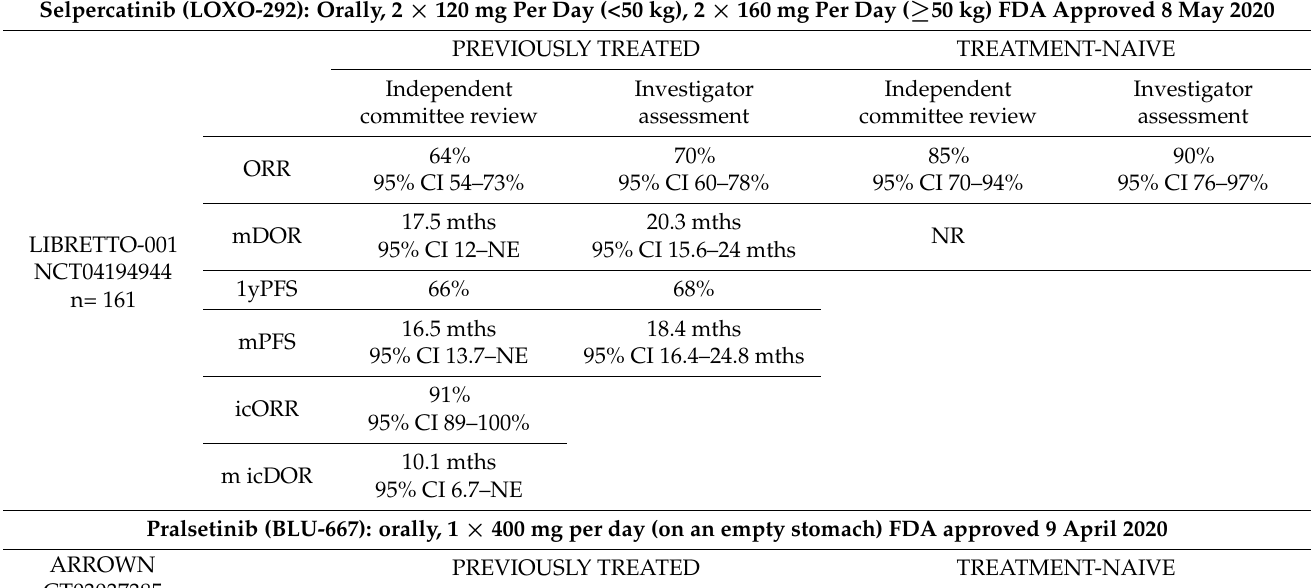
Table 4. The detailed results on selpercatinib and pralsetinib